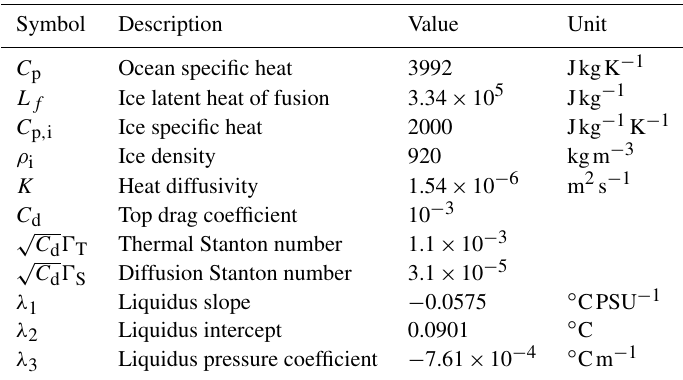
Table 1. Parameters used in the ice-shelf–ocean interaction formulation.